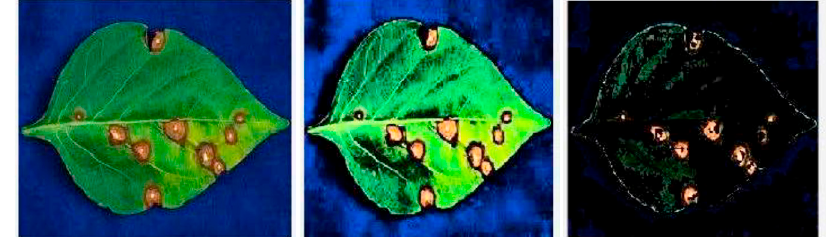
Figure 3. Capsicum leaf segmented, with infected regions highlighted; 100% accuracy achieved for Support Vector Machine (SVM) and K-Nearest Neighbors (KNN) classifiers [26].